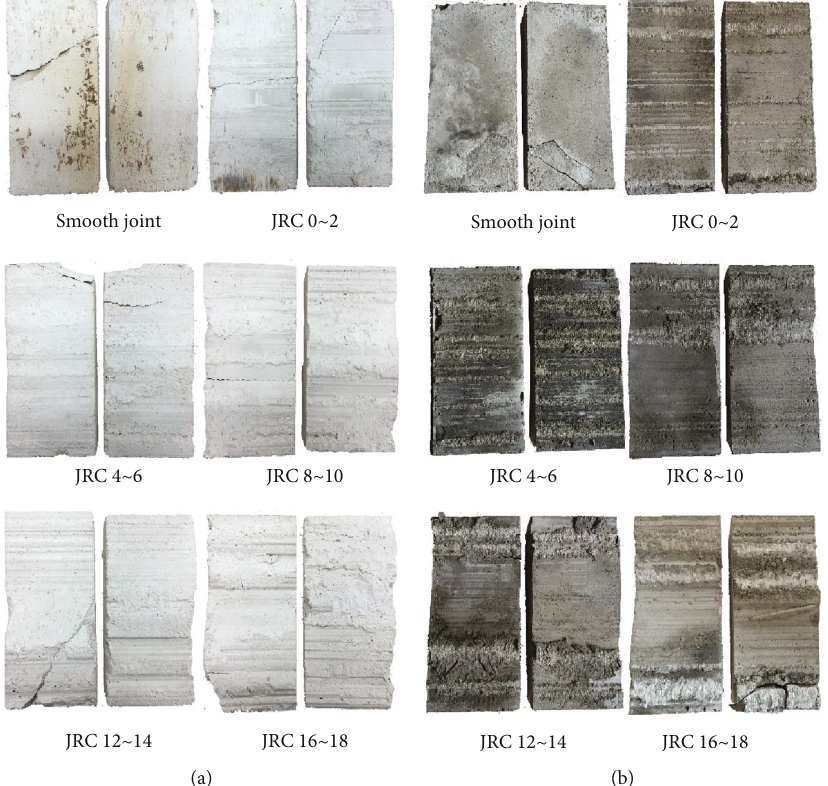
Figure 5: Shear failure model of low-strength rock joints and high-strength rock joints: (a) low-strength rock joint; (b) high-strength rock